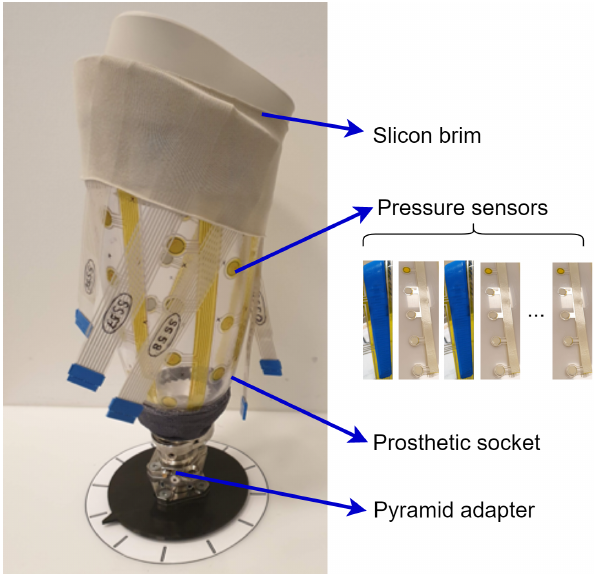
Figure 2. Prosthetic check socket with sensors